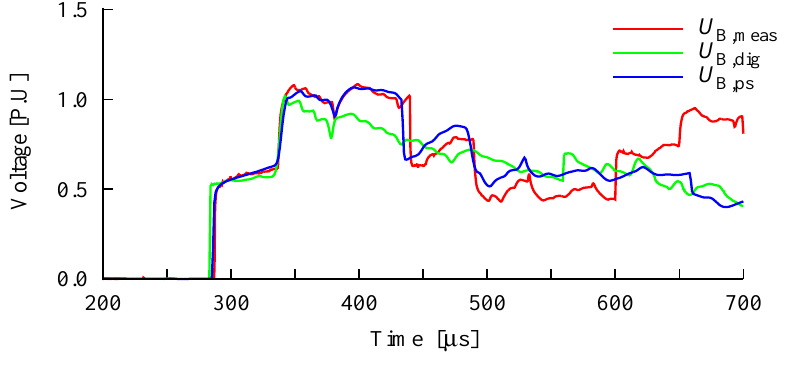
Figure 8. Comparison of measurement data and DigSILENT and PSCAD simulation. Results at A1.